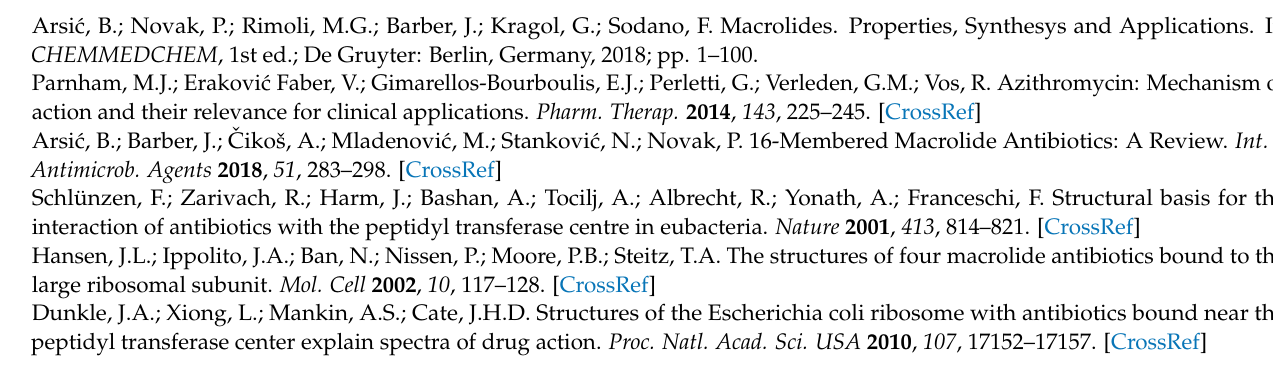
Figure S8. (a) overlaid proton spectra of the 3a-7 and 3a , (b) COSY spectrum, (c) overlaid HSQC spectrum of the 3a-7 and 3a (blue and green contours belong to the 3a-7 , while red and pink contours belong to the 3a ; signals from unknown impurities are marked with asterisk*), (d) HMBC spectrum and (e) MS spectrum of the compound 3a-7 , Figure S9. (a) proton spectrum, (b) COSY